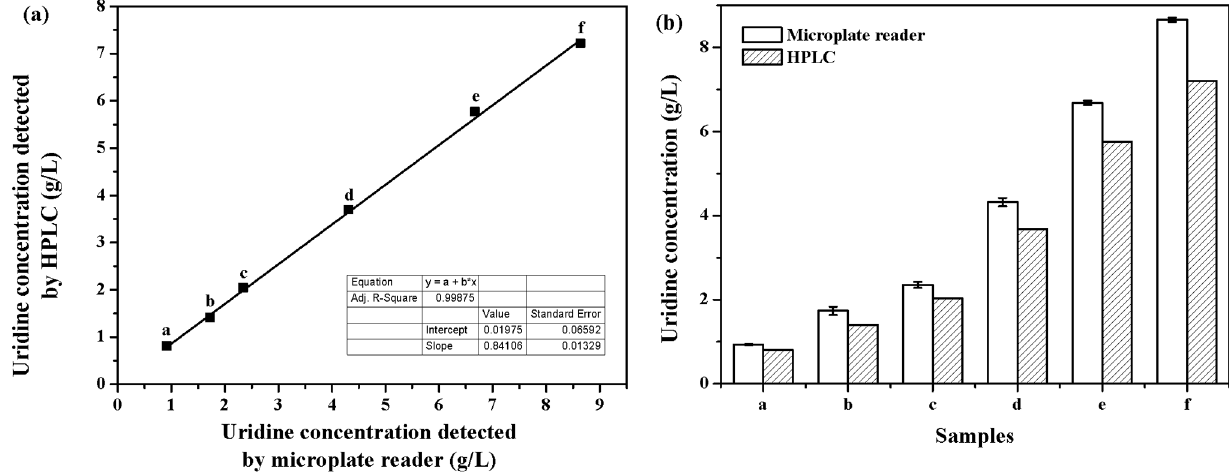
Fig 2. Comparison of uridine concentration detected by microplate reader and HPLC. (a) Correlationcoefficient of the two methods; (b) Measuredvalues of uridineconcentration in microplate. Each plot representsthe averageof three samples.